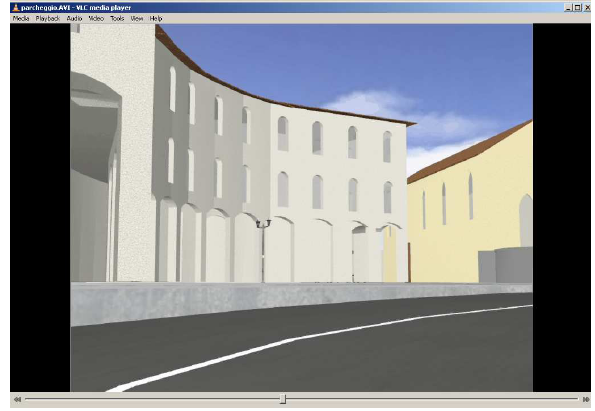
Figure 12. Sample of view from the street level